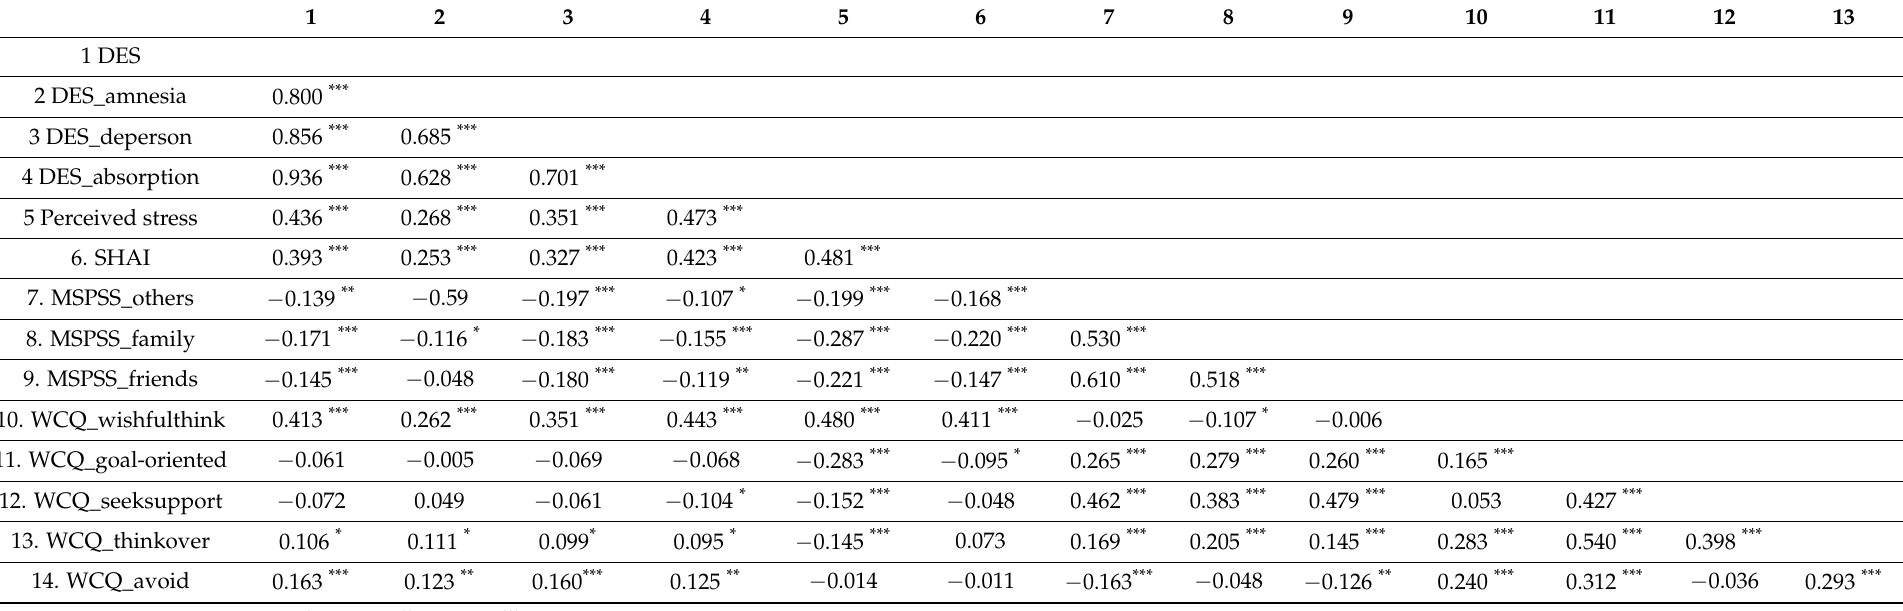
Table 4. Correlation matrix for the international sample.